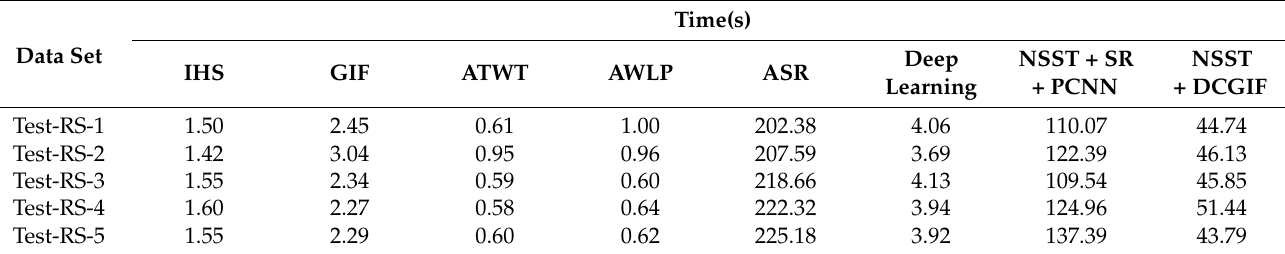
Table 6. Time complexity statistics of different fusion